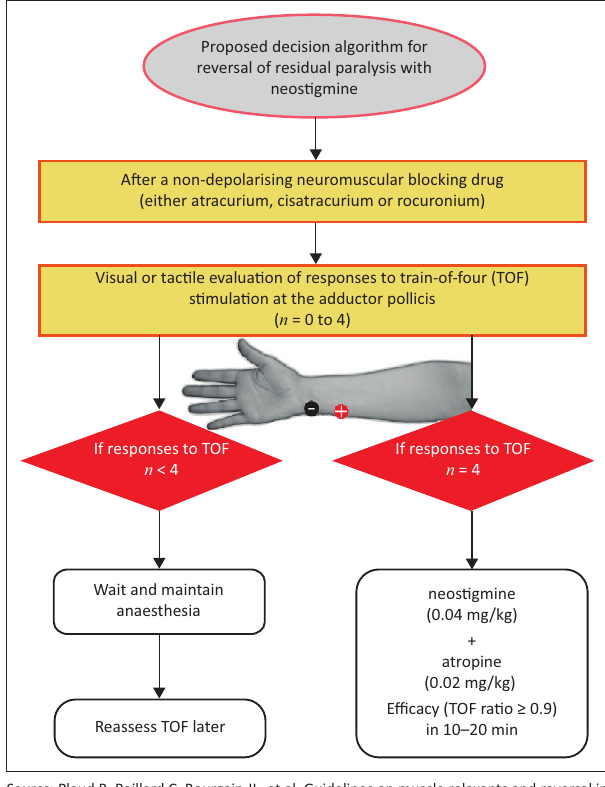
FIGURE 1: Decision algorithm for reversal using neostigmine.